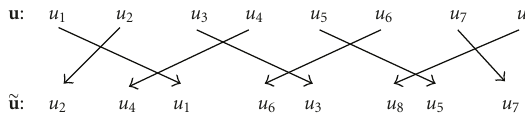
Figure 5: Mapping function of